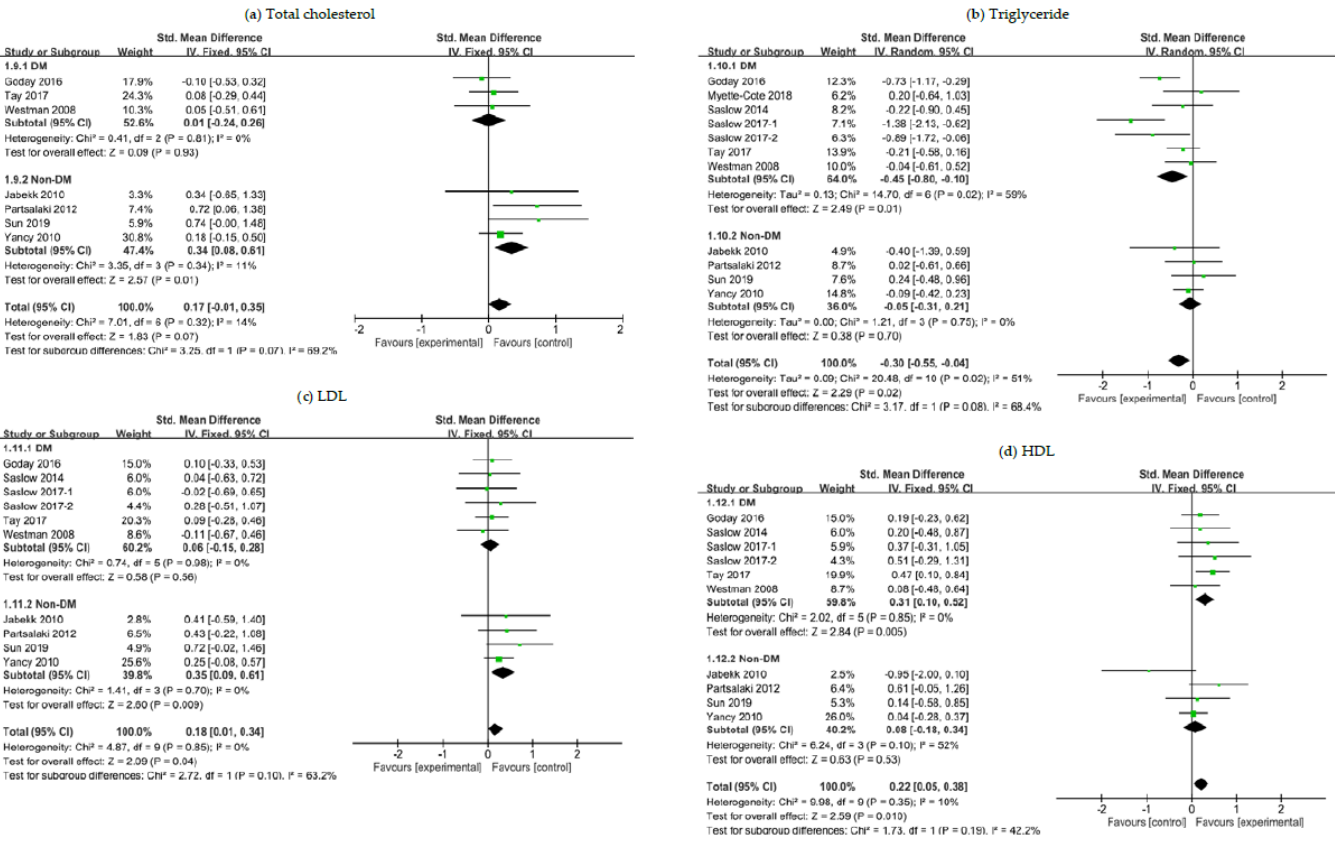
Figure 5. Forest plots for association between lipid control and ketogenic diet in patients with overweight or obesity and with or without T2DM: ( a ) Changes in total cholesterol; ( b ) changes in triglyceride; ( c ) changes in LDL; ( d ) changes in HDL. Abbreviations: CI, confidence interval; DM, diabetes mellitus; Non-DM, non-diabetes mellitus; LDL, low-density lipoprotein; HDL, high-density lipoprotein; T2DM, type 2 diabetes mellitus.